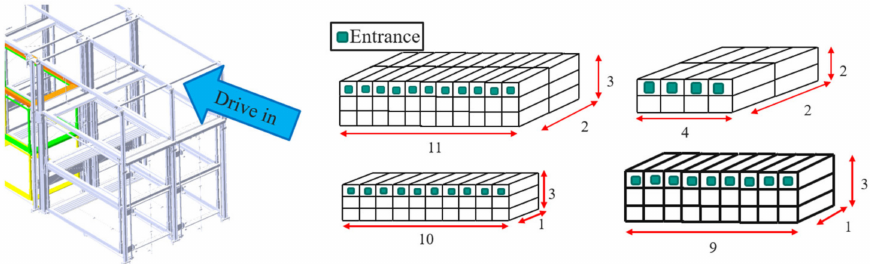
Figure 8. The system-of-interest (SOI): semi-automated parking system ( left ) and its configurations ( right ).